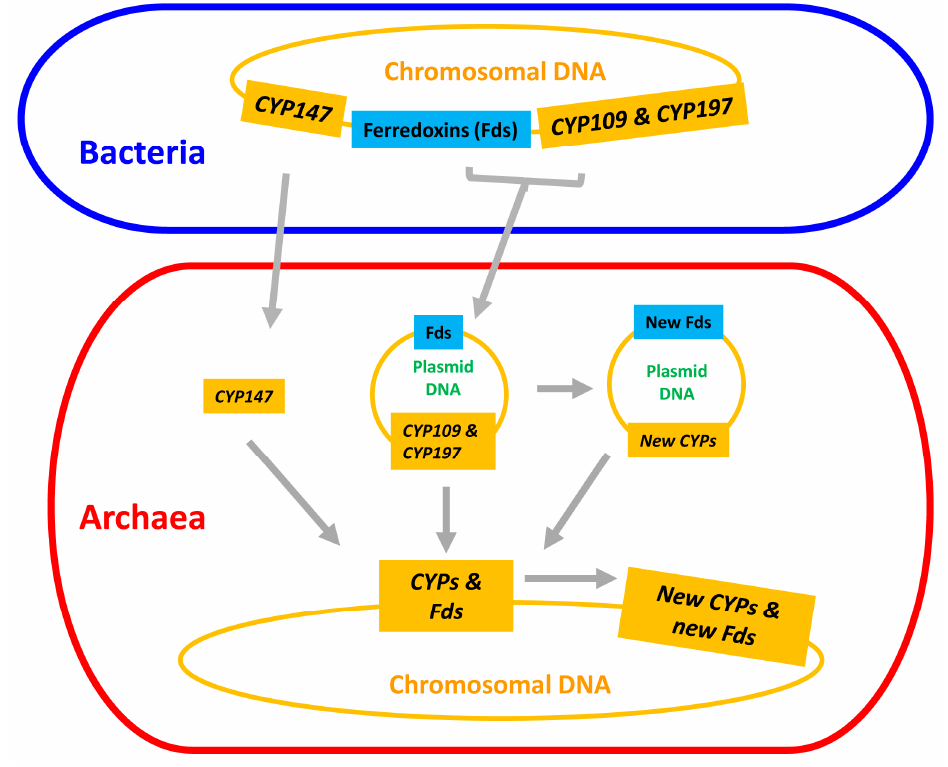
Figure 7. Schematic representation of evolution and diversification of P450s/CYPs and ferredoxins in archaea.